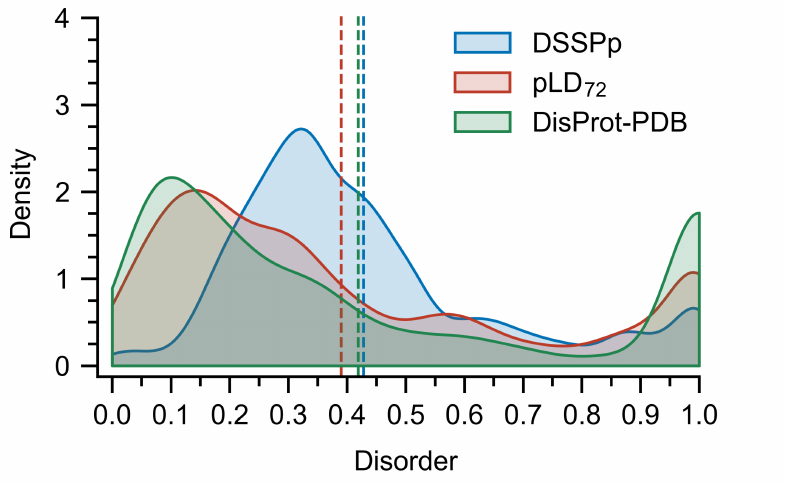
Figure 3. Distribution of disorder content per protein in the DisProt-PDB dataset depicted alongside the distributions predicted by pLD 72 and DSSPp. Bin-widths were set at 0.5 and bootstrapping that is, sampling with replacement, was used to compute the distributions and average values (vertical dashed lines) with 10,000 samples of size 60. Close agreement between the experiment and pLD 72 is evident, conversely, DSSPp predicted a higher disorder content. pLDDT is abbreviated pLD for plotting